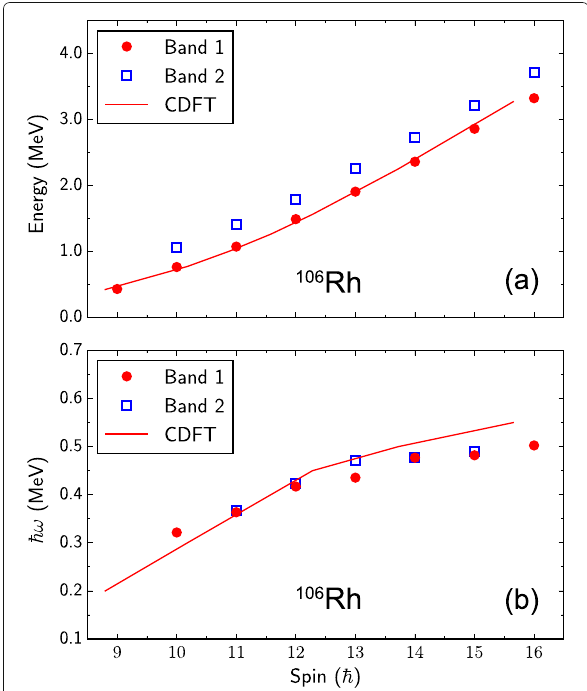
Fig. 4 Calculated rotational excitation energies (top) and rotational frequencies (cid:2) ω (bottom) for the observed chiral bands in 106 Rh, in comparison with data. Taken from